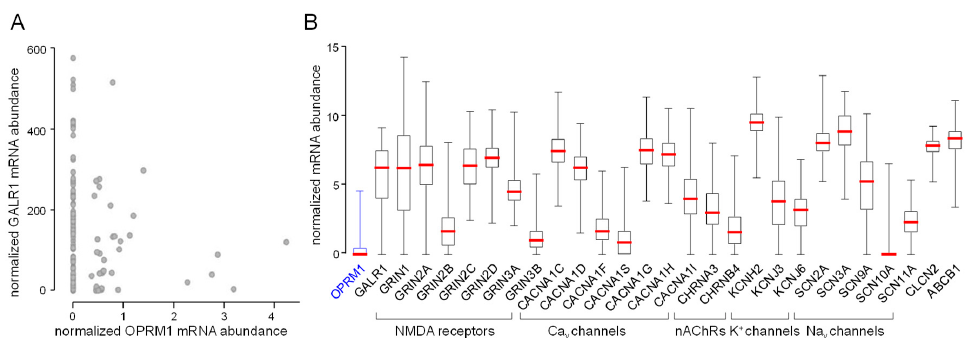
Figure 1. Expression of methadone target molecules in glioblastoma (Illumina HiSeq_RNA Seq V2 glioblastoma dataset (n = 172) of The Cancer Genome Atlas (TCGA)) . ( A ) Majority of glioblastoma specimens exhibit non-detectable low abundances of the µ-opioid receptor (OPRM1) mRNA. Here, the µ-opioid receptor mRNA abundances are plotted against those of the GALR1 (galanin receptor 1), which forms heteromeric receptors with OPRM1 (values of individual tumors are shown). ( B ) Box whisker plots depicting relative mRNA abundances (TCGA-normalized values) of proposed methadone targets in glioblastoma specimens (medians are highlighted by red lines). Ca v channels: voltage-gated L- and T-type Ca 2+ channels, nAChRs: nicotinic acetylcholine receptors, NMDA receptors: N -methyl- D -aspartate receptors, Na v channels: voltage-gated Na + channels, KCNH2: hERG1 K + channel, CLCN2: ClC-2 Cl − channel, ABCB1: p-glycoprotein (MDR1).